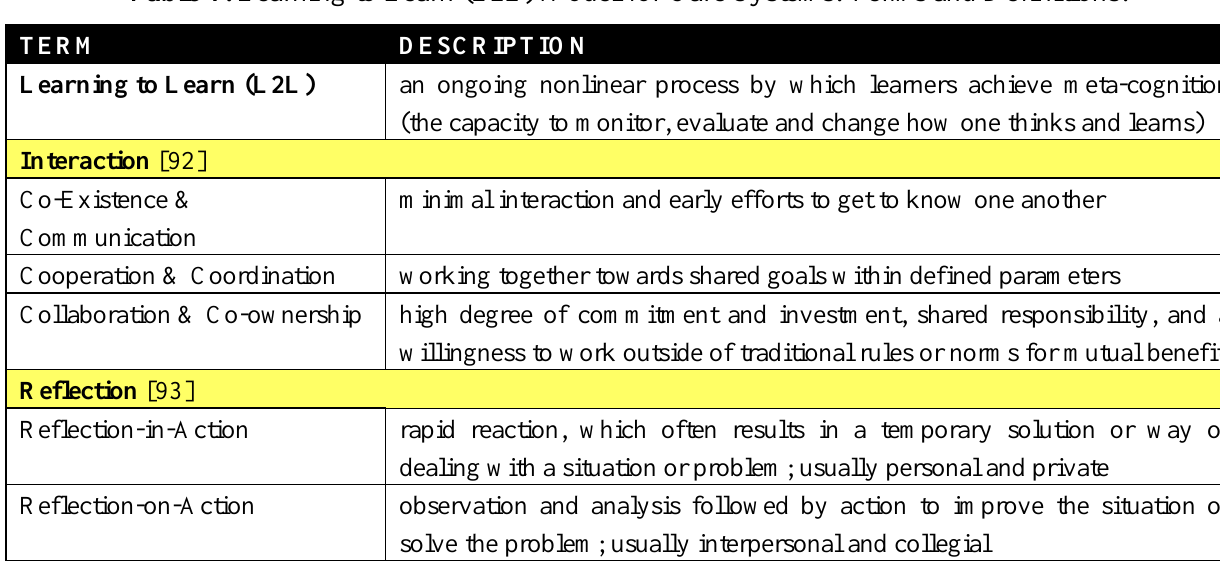
Table 1. Learning to Learn (L2L) Model for Care Systems: Terms and